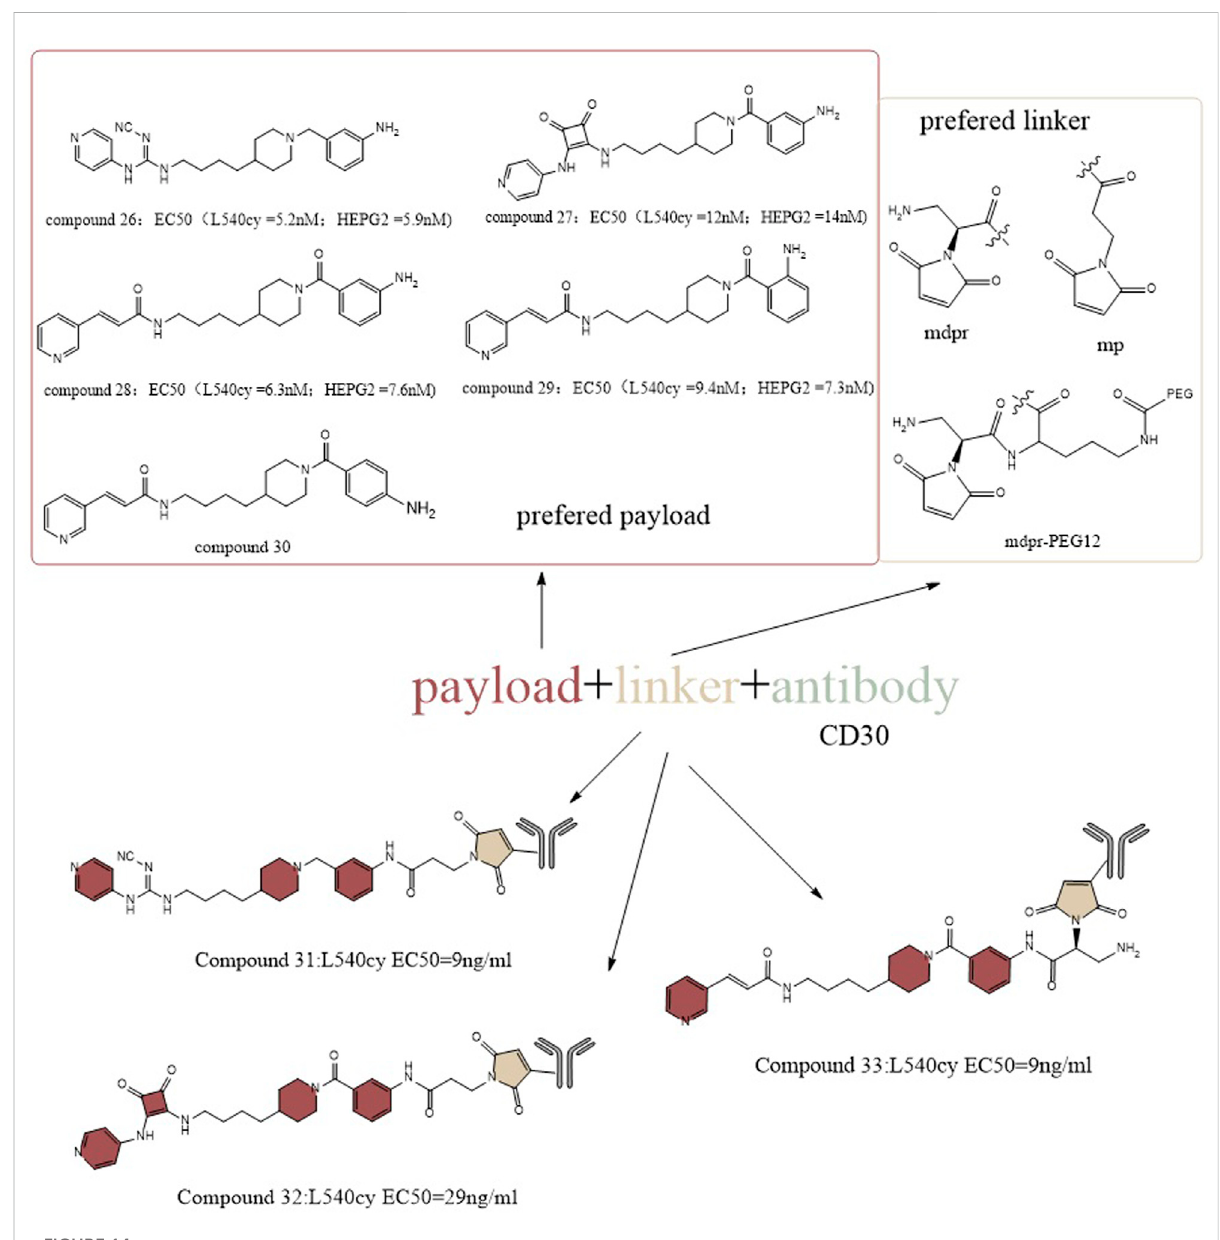
FIGURE 14 Structural design of